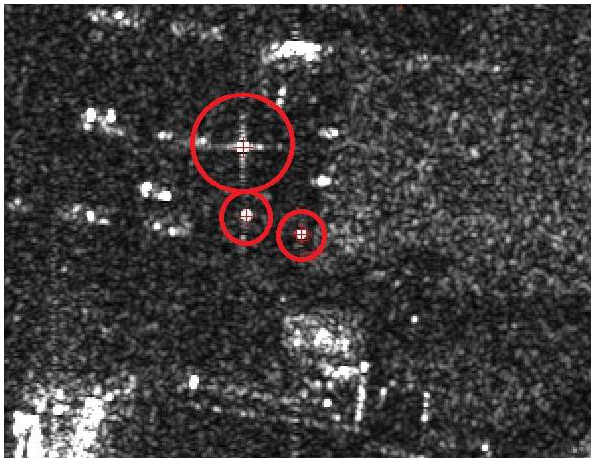
Figure 13. A large and two small reflectors in the SAR data 4.3. Summarized results for corner reflectors The RMS equals 0.41 m horizontal and 0.50 m vertical.